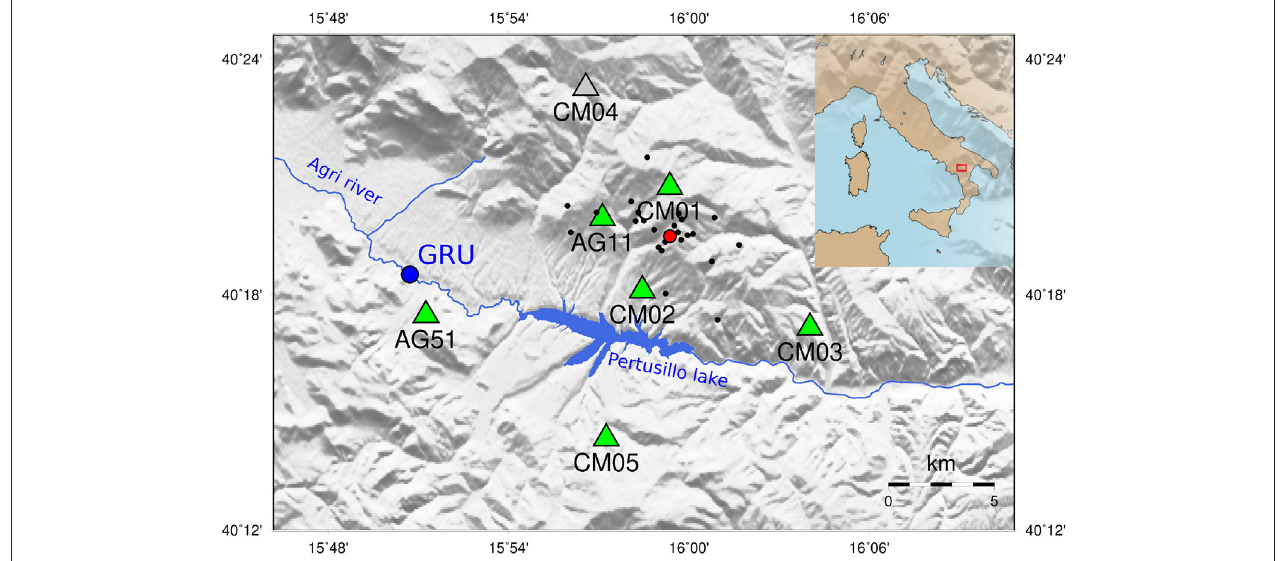
FIGURE 2 | Seismic network (green) around the Val d’Agri oil field and Costa Molina re-injection well (red). Black dots indicate the 2015 recorded seismicity (25 events with − 0.1 < M L < 0.8.). Seismic station CM04 (gray) has not be used due to irrecoverable technical problems with the clock. Blue dot indicate the Ponte Grumento meteorological station.